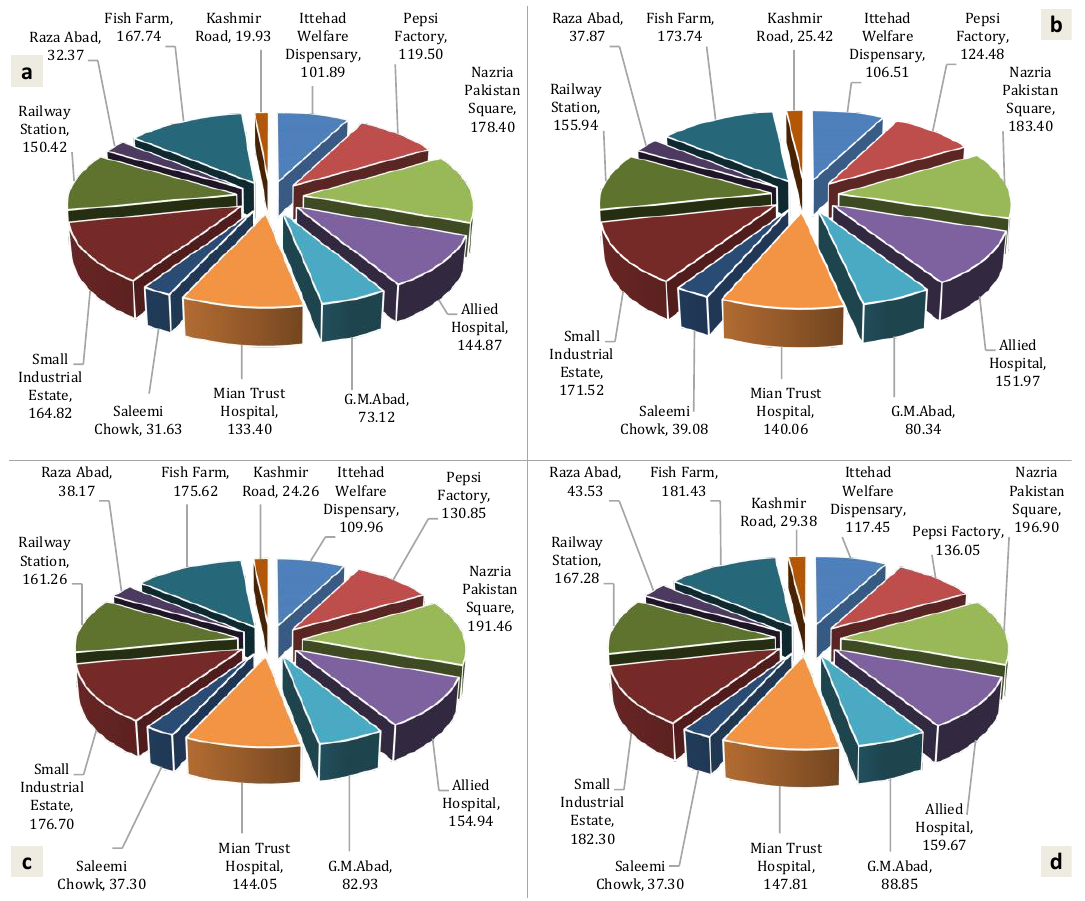
Figure 4. Concentration of carbonaceous species—organic carbon (OC) in PM 2.5 in summer ( a ); PM 2.5 in winter ( b ); PM 10 in summer ( c ); PM 10 in winter ( d ). All units are expressed in μg/m 3 .